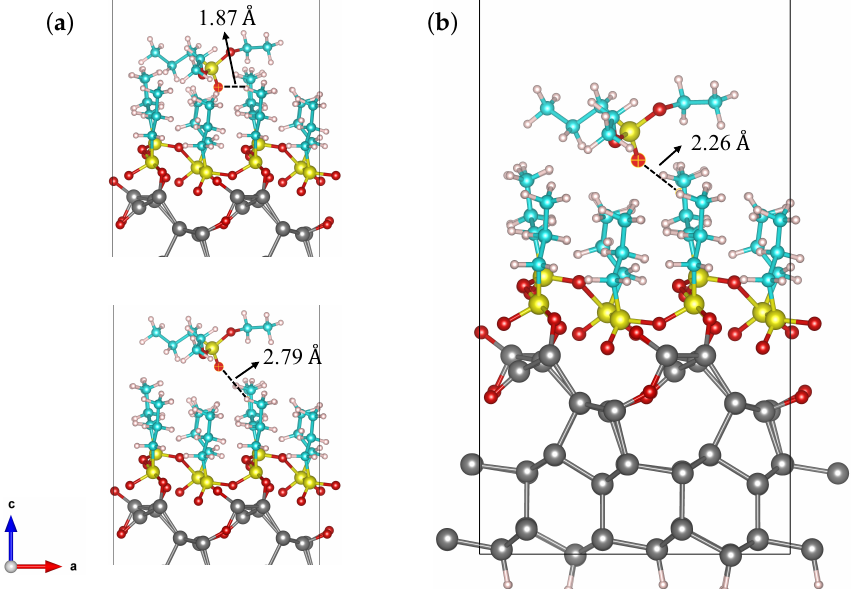
Figure 6. ( a ) The initial DPP positions including shorter ( top panel ) and longer ( bottom panel ) vertical distances from the first layer and ( b ) the most stable structure of physisorbed DPP on a Si (111) 2 × 1 reconstructed surface covered by a broken DPP